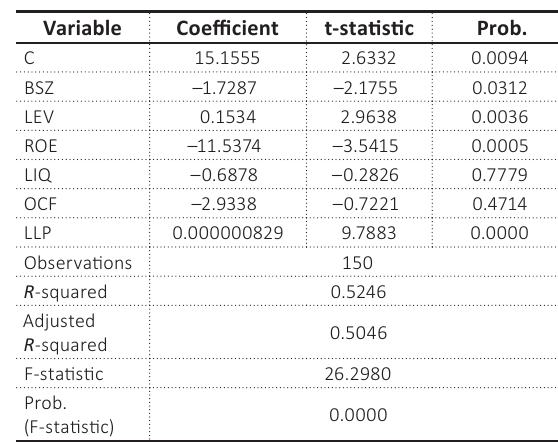
Table 5. Regression results of the model Source: Analytical data from Eviews